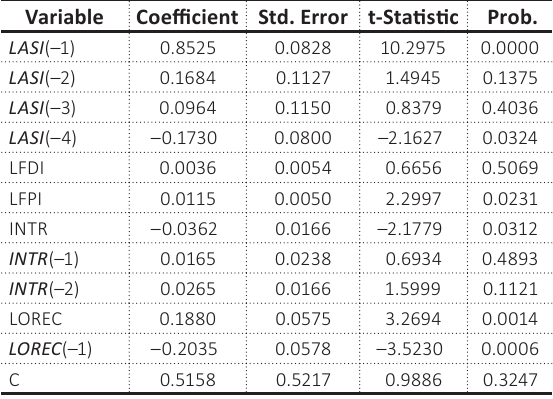
Table 7. ARDL test